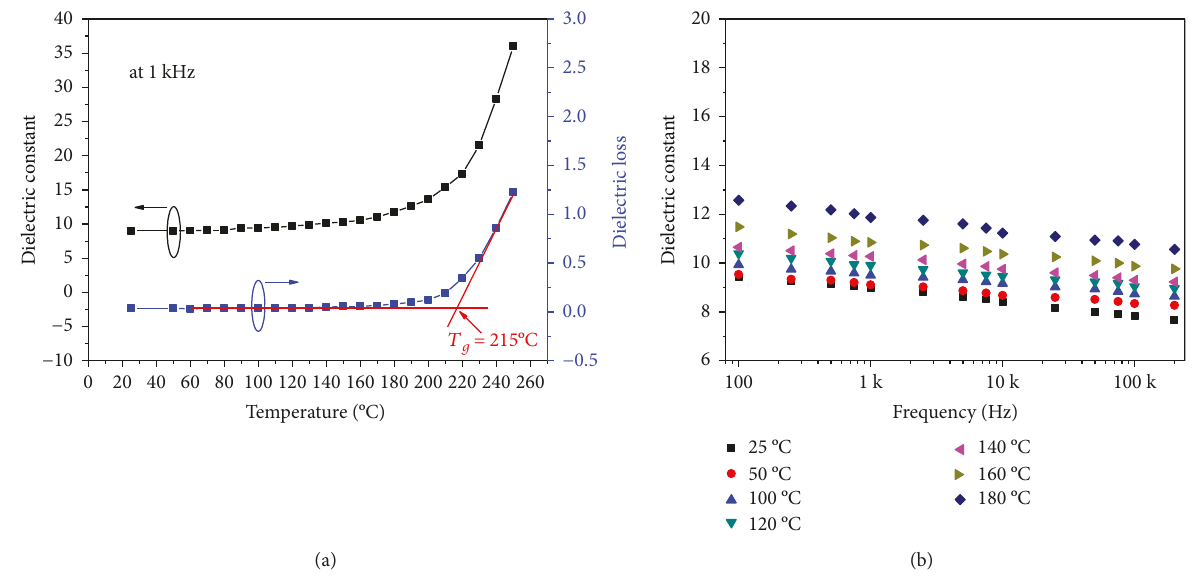
Figure 7: The permittivity-frequency properties of BT@CPEN@CuPc/PEN (20 wt%).